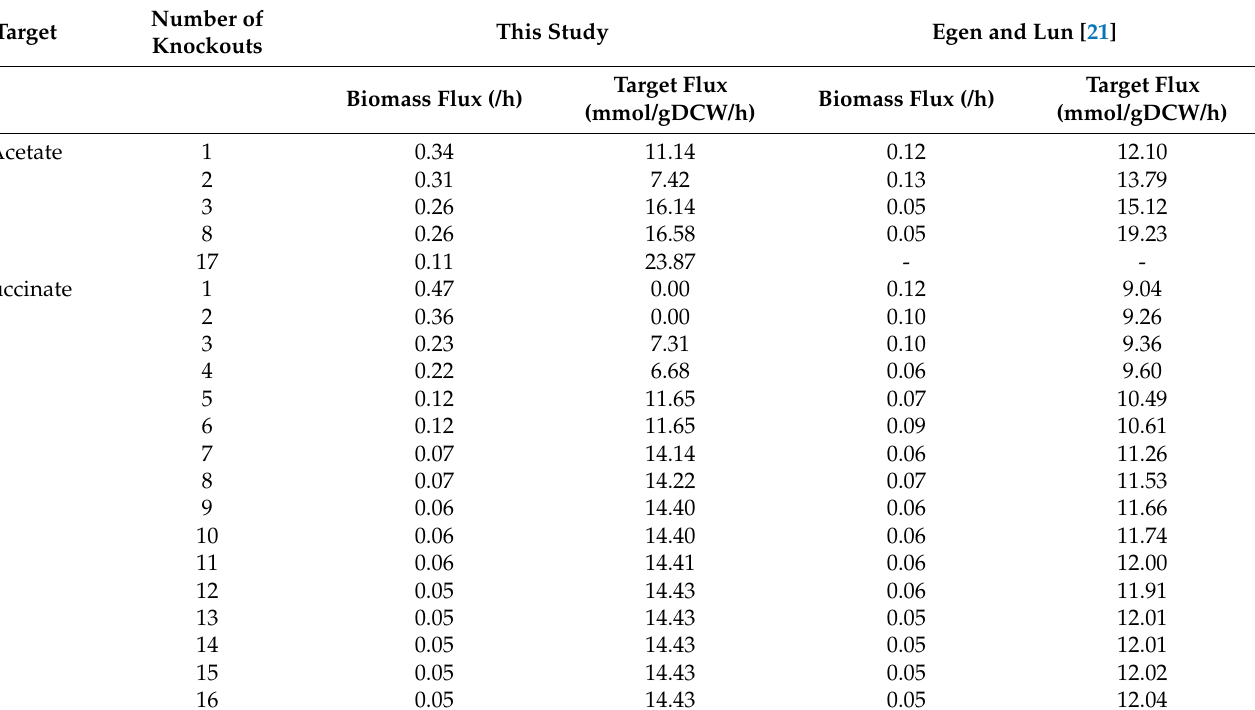
Table 1. Comparison between the results obtained using the method proposed in this study and the method described by Egen and Lun [21] for the production of acetate and succinate. The number of knockouts and the growth and production fluxes of the target compounds are described below. See Supplementary Table S6 for details of the deletion